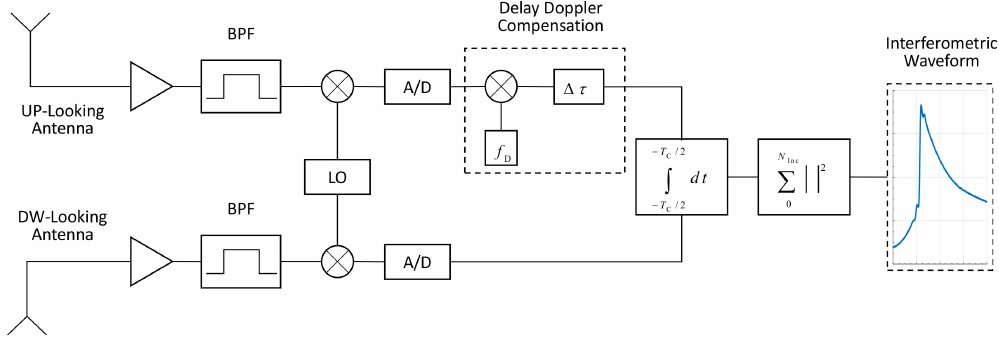
Figure 1. A simplified block diagram of an interferometric Global Navigation Satellite System Reflectometry ( i GNSS-R)